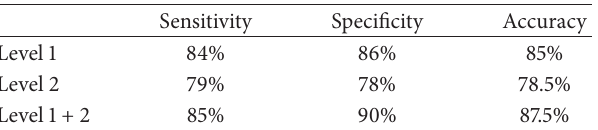
Table 9: Results obtained using DWT + ULBP [7] in HSV color space.